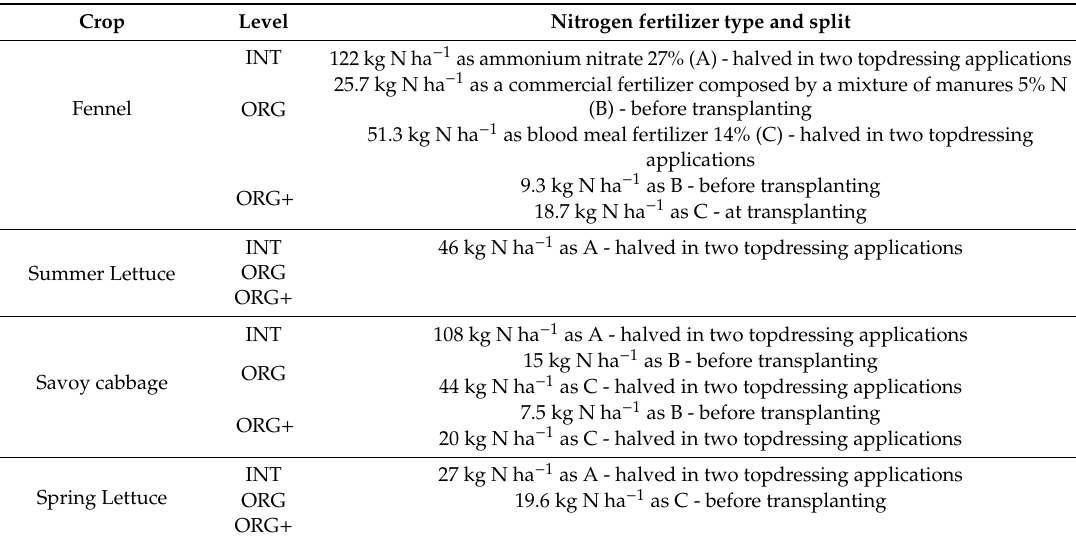
Table 3. Type and splitting of fertilizers in the three cropping systems for each